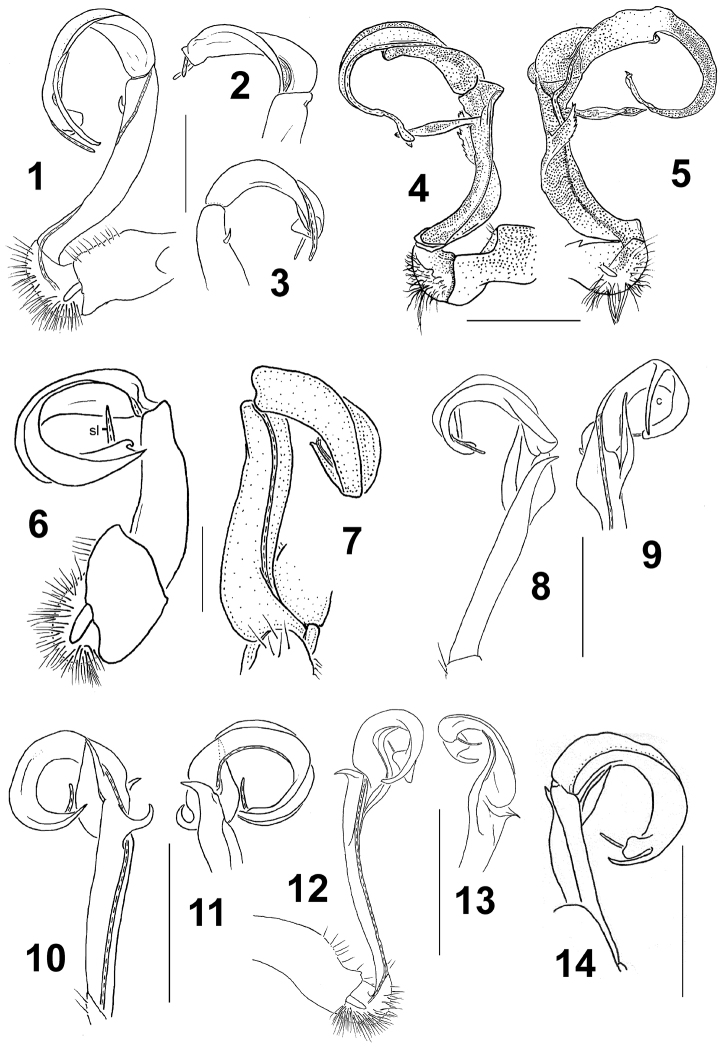
Gonopodal structural variations between several species of Beronodesmus: B.
martensi Golovatch et al., 2016 (1–3), B.
serratus Golovatch et al., 2016 (4, 5), B.
simplex Golovatch, 2016 (6, 7), B.
distospinosus Golovatch, 2015 (8, 9), B.
latispinosus Golovatch, 2015 (10, 11), B. sinuatospinus Golovatch, 2015 (12, 13) and B.
gorkhalis Golovatch, 2015 (14). Scale bars: 1.0 mm (4–5, 14), 0.5 mm (1–3, 8–13) or 0.4 mm (6, 7). After Golovatch (2015a, 2016c) and Golovatch et al. (2016).